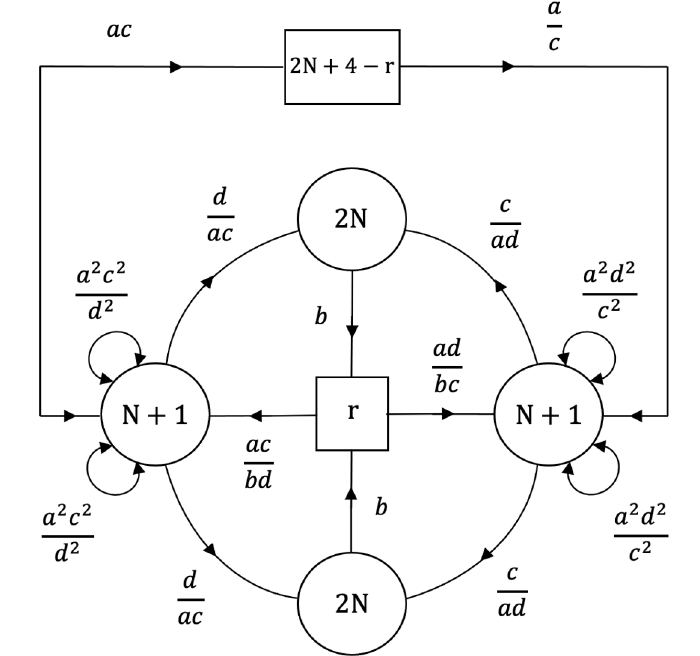
Figure 6 . The 3 d quiver theory associated with the compactification of the 5 d SCFT with SU(2) × SO(4 N + 8) global symmetry on a torus with flux preserving U(1) 2 × SU( r ) × SO(4 N + 8 − 2 r ) . There is a cubic superpotential for each triangle of the quiver and for each antisymmetric chiral coupling it to two bifundamentals. In addition, there is a quartic superpotential coupling the SU( N + 1) × SU(2 N + 4 − r ) bifundamentals to the USp(2 N ) × SU( N + 1) bifundamentals along the semi